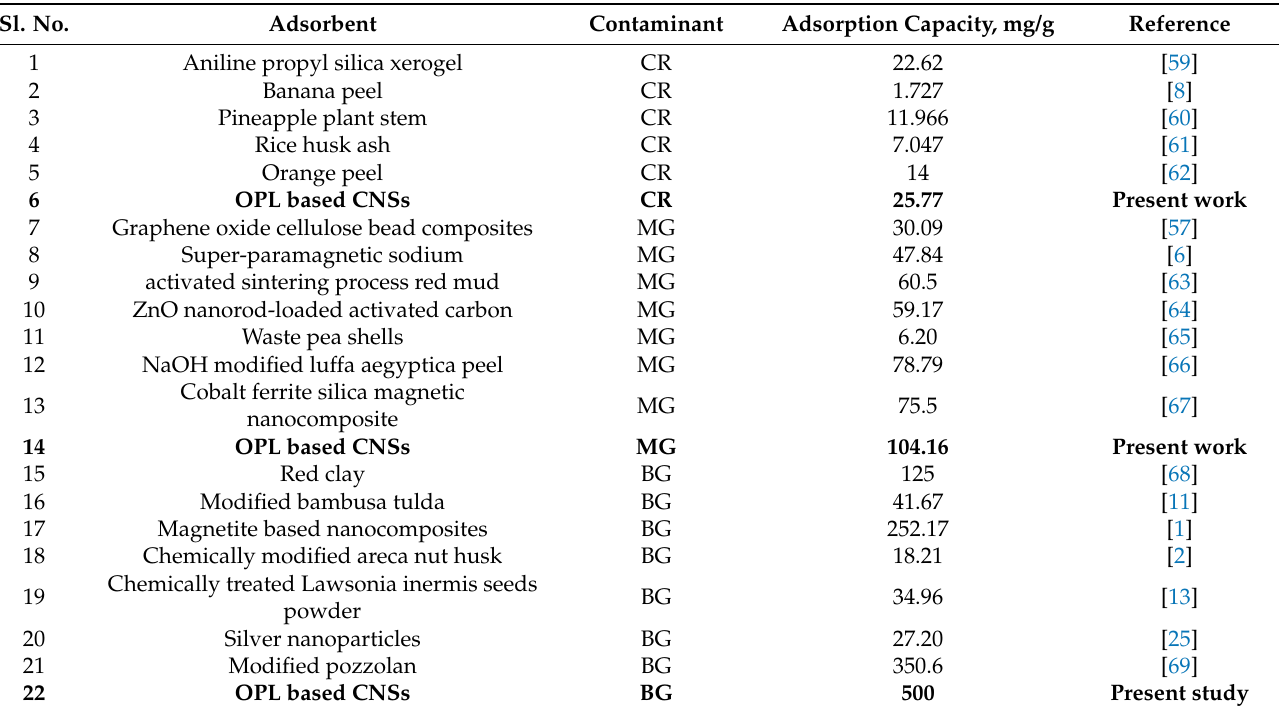
Table 3. Comparison of adsorption capacity of various adsorbents reported in the removal of dyes. Sl.